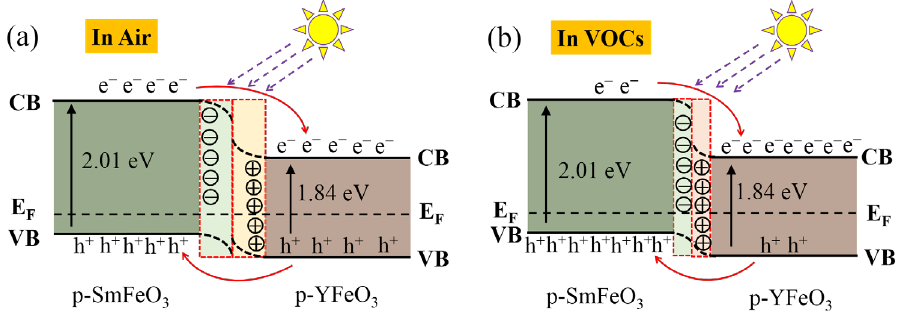
Figure 15. Schematic diagram of the energy band of the SmFeO 3 /YFeO 3 composite material ( a ) in air and ( b ) VOC gases.